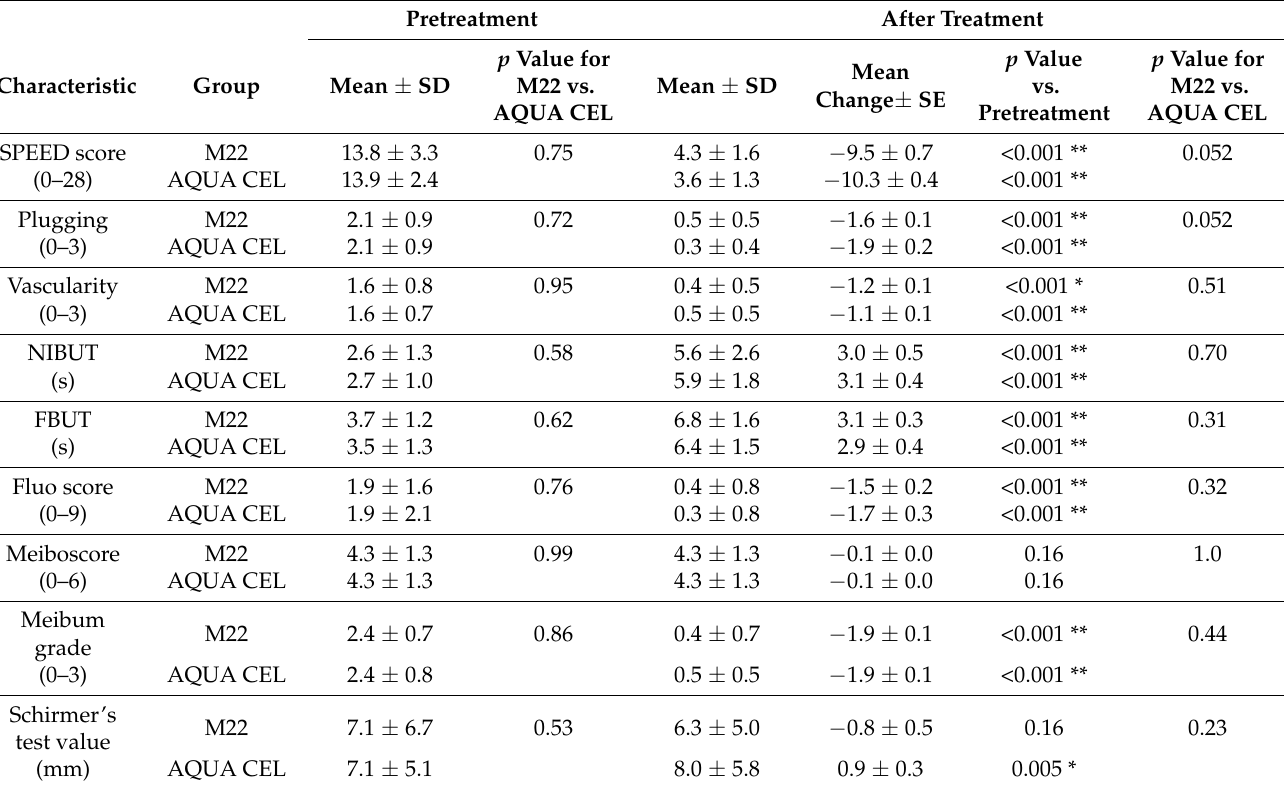
Table 4. Comparison of M22 and AQUA CEL groups before and one month after the final treatment session. Pretreatment After